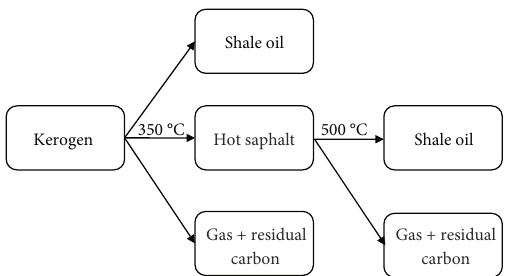
Figure 7: Flowchart of the pyrolysis of oil shale.